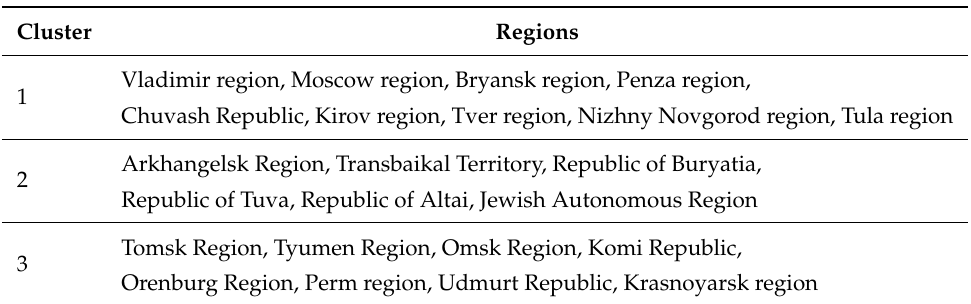
Table 1. Stable regions.